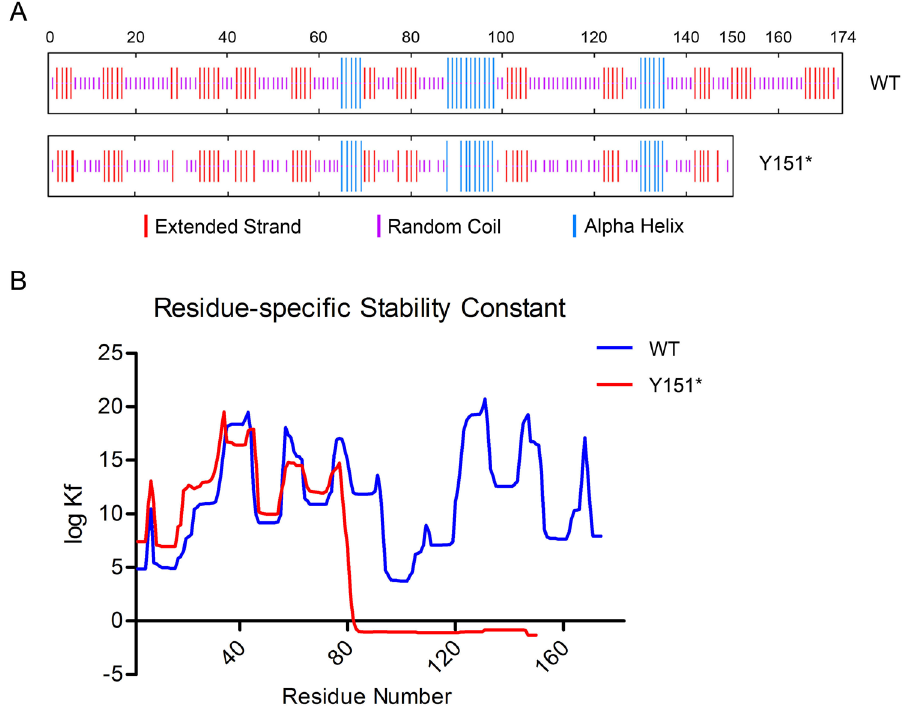
Fig 3. Bioinformatics analysis of the mutant CRYGD Y151 * . (A) The predicted secondary structure showing the reduced extended strand and random coil in the mutant. (B) The C-terminal domain of the truncated CRYGD favors the unfolded state. The residue-specific stability constant (K f ) for each residue of the protein was predicted by the BEST/COREX server.